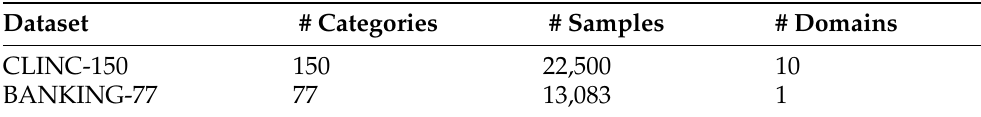
Table 1. Statistics of CLINC-150 and